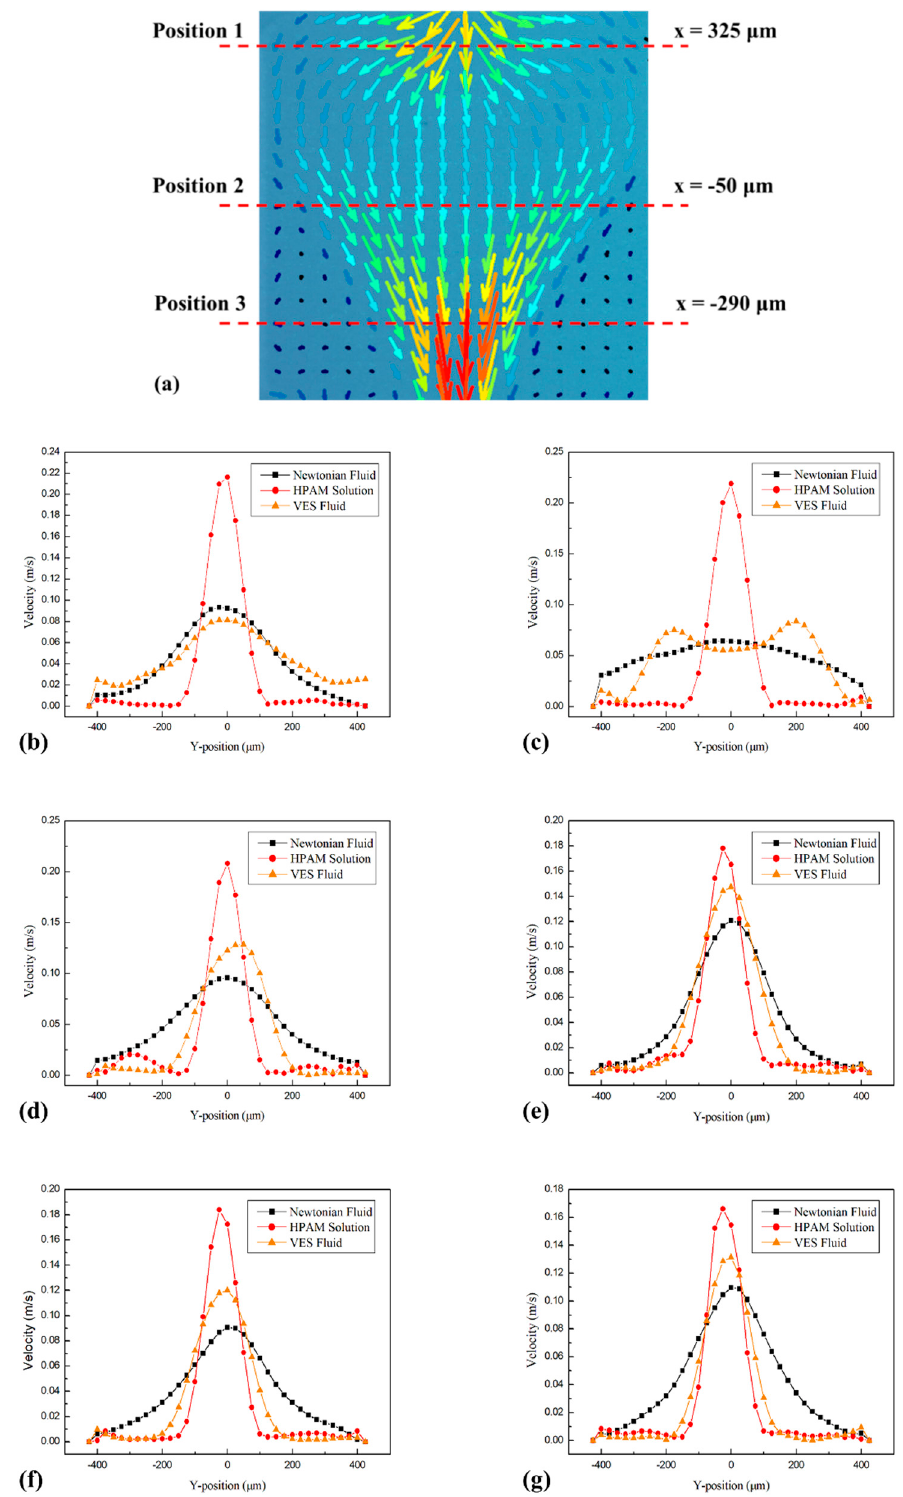
Figure 8. ( a ) The schematic of velocity line positions; Velocity magnitude maps of the Newtonian fluid, HPAM solution and VES fluid in long continuous pore-throat structure at ( b ) x = 325 µ m; ( c ) x = − 50 µ m, ( d ) x = − 290 µ m and in short continuous pore-throat structure at ( e ) x = 150 µ m, ( f ) x = 0 µ m, ( g ) x = − 75 µ m.